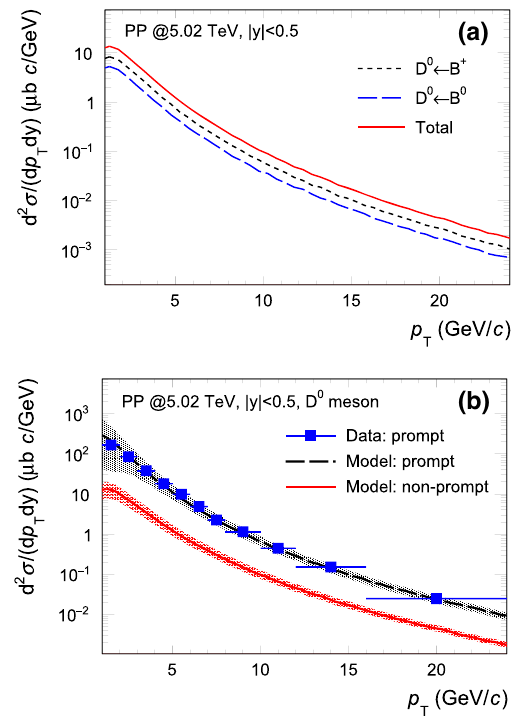
Fig. 4 Upper: comparison of the central values of the p T -differential production cross section for non-prompt D 0 mesons at midrapidity √ s = 5 . 02 TeV obtained from different ( | y | < 0 . 5) in pp collisions at decay channels: D 0 ← B + (dashed black curve) and D 0 ← B 0 (long dashed blue curve); The combined result (solid red curve) is shown as well; Bottom: same as above but for the comparisons between prompt and non-prompt productions from the model and the available experi- mental data